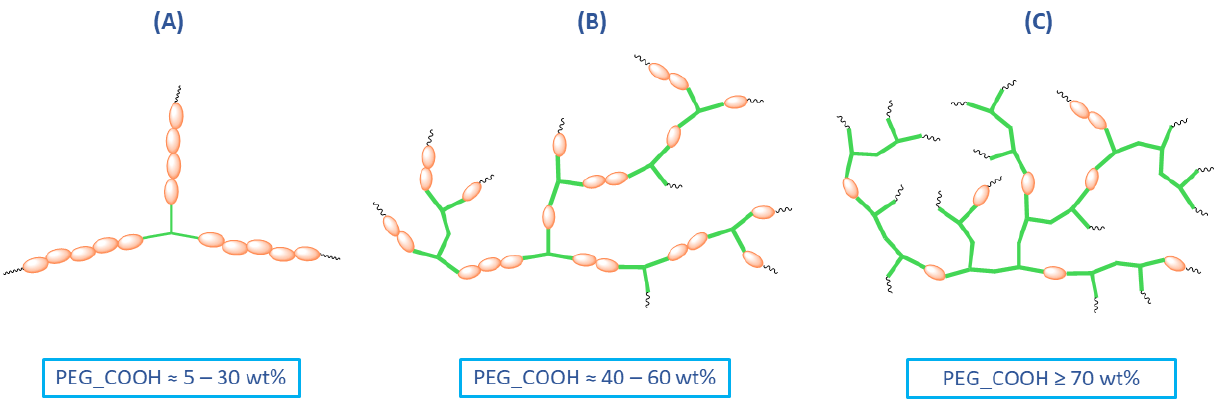
Figure 6. Three types of DBB — PEG(COOH) 3 branched polyanhydrides: (A) structure of polyanhydrides containing 5 – 30 wt% of PEG_COOH; (B) structure of polyanhydrides containing 40 – 60 wt% of PEG_COOH; (C) structure of polyanhydrides containing ≥ 70 wt% of PEG_COOH.